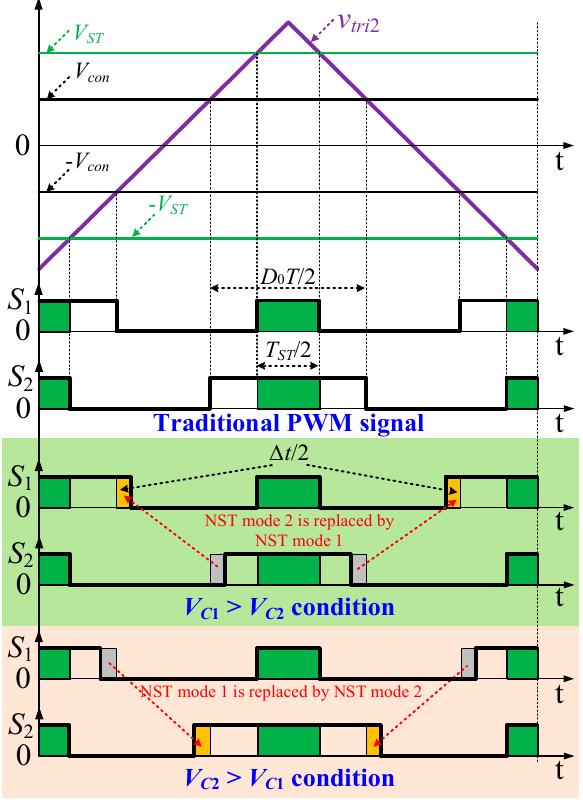
Figure 5. PWM generation for capacitor voltage balance.